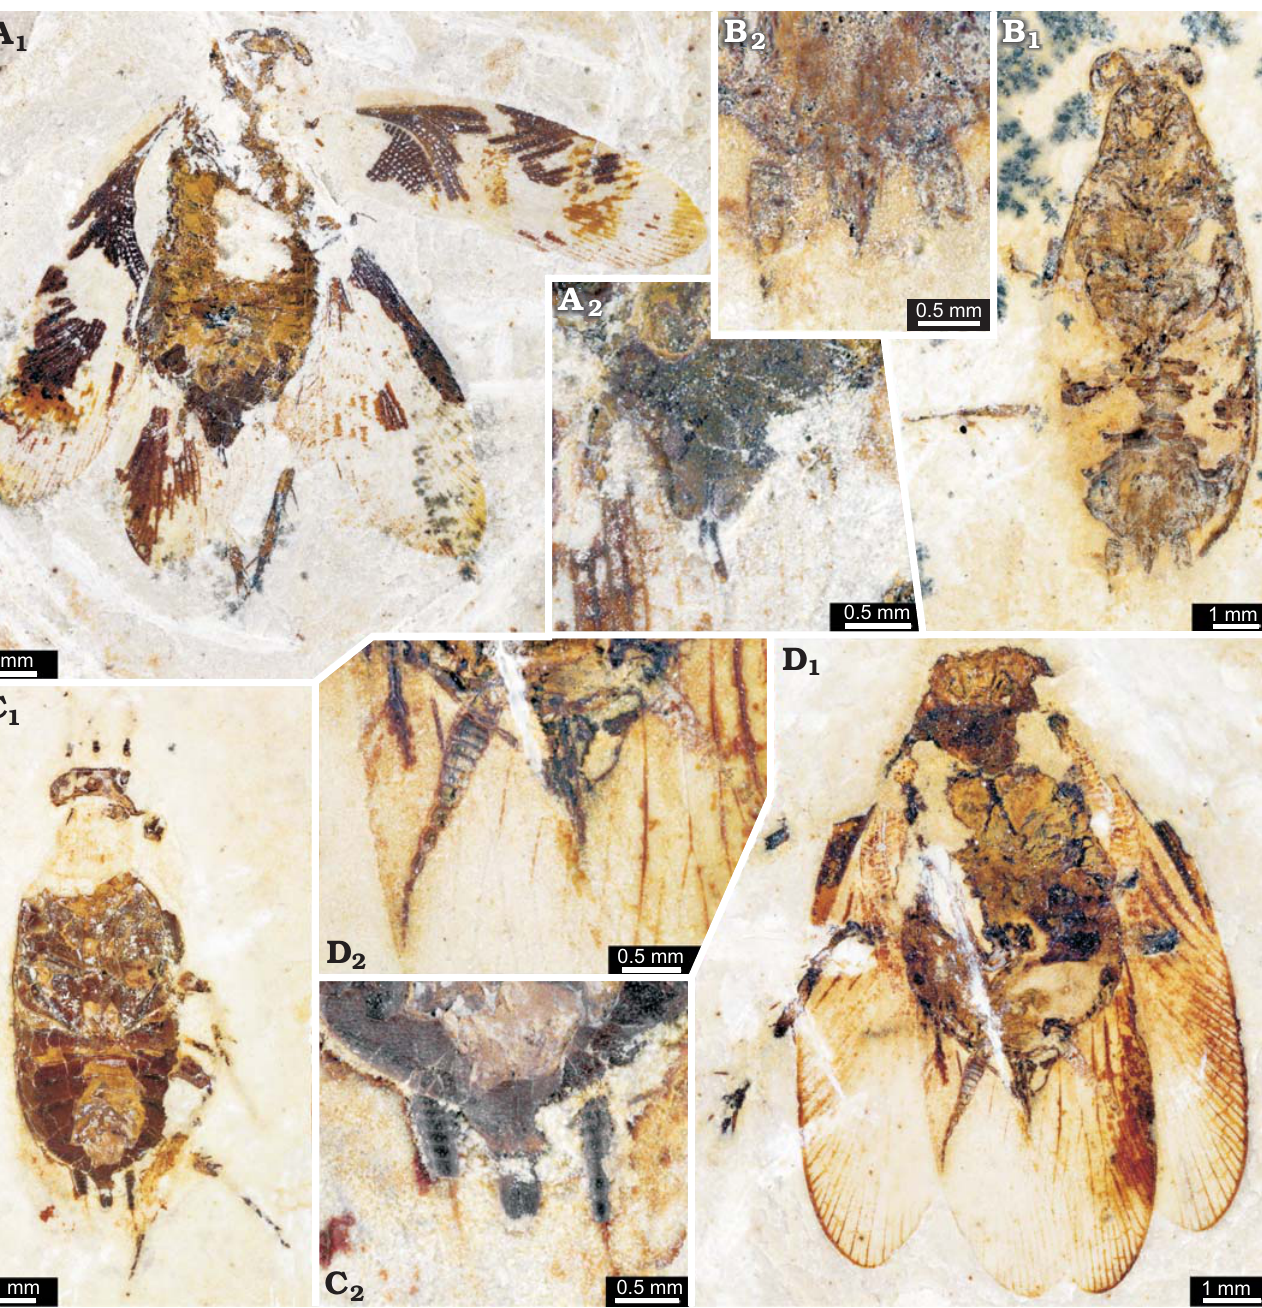
Fig. 12. Ponopterix maxima Bechly, 2007 (B, C) and undescribed cockroaches or roachoids (A, D) from the Aptian, Cretaceous Crato Formation of Brazil; in ventral views. A . ROMIP64637. B . ROMIP64639. C . ROMIP64640. D . ROMIP64641. A 1 –D 1 , overviews; A 2 –D 2 , close ups of the